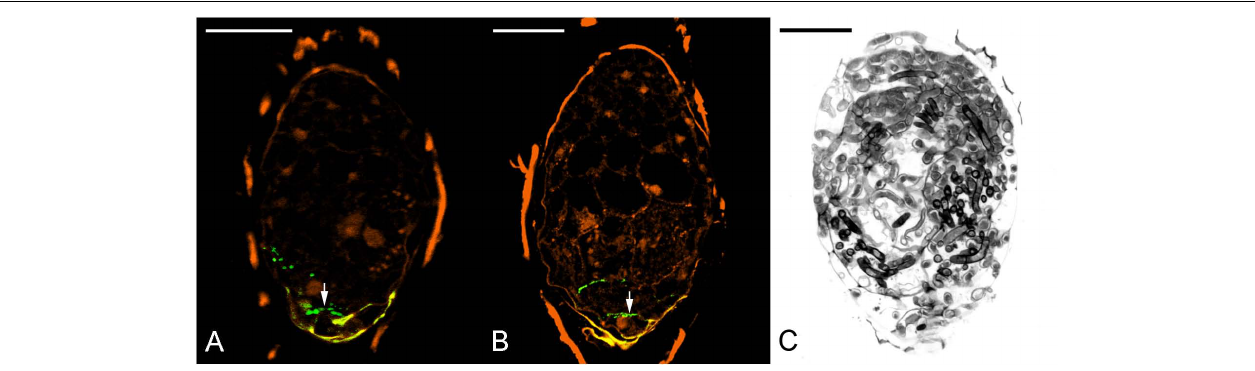
FIGURE 8 | The effect of 3,4-DHP on the localization of JIM11 epitope during symbiotic seed germination of D. officinale . (A) After 3 weeks of inoculation, most embryos did not enlarge, and weak signals of JIM11 epitope (arrow) are observed in the walls of basal end of the embryo. Scale bar = 50 µ m. (B) After 3 weeks of inoculation, the infected embryo showing weak signals of JIM11 epitope (arrow) in the walls of basal end of the swollen embryo. Scale bar = 50 µ m. (C) Most seeds in the treatment with 3,4-DHP are unable to germinate, and the severe fungal invasion in the ungerminated seeds could be commonly observed. Scale bar = 50 µ m.